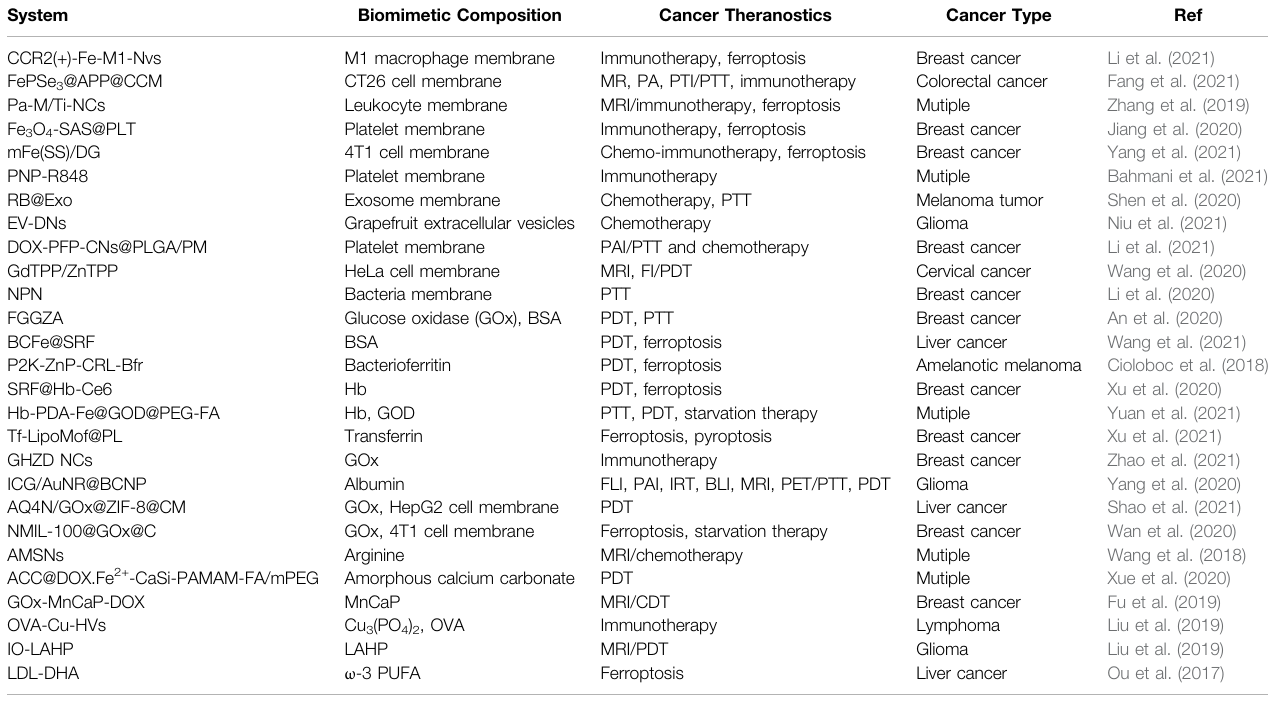
TABLE 1 | Biomimetic nanomaterials for cancer theranostics. System